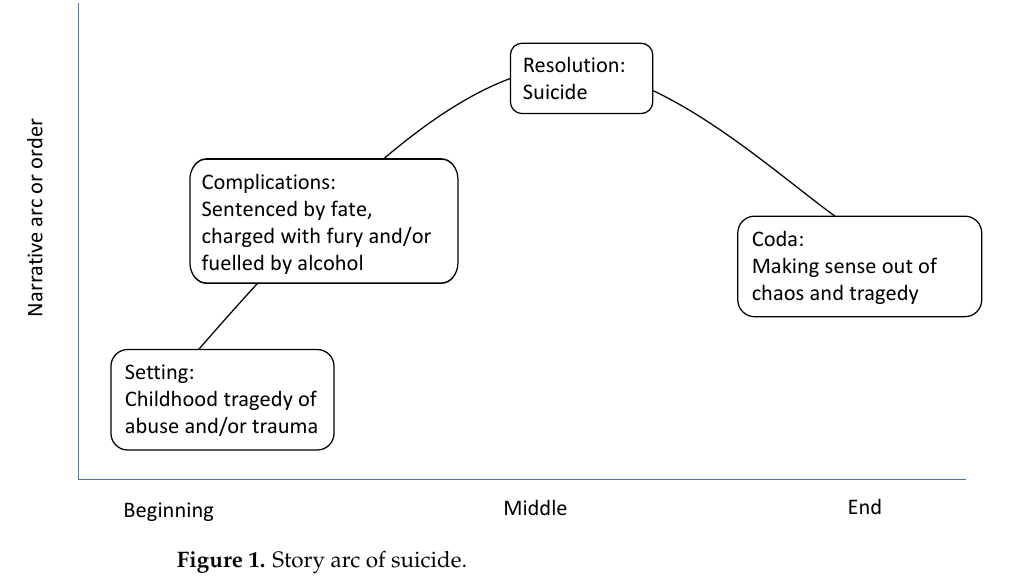
Figure 1. Story arc of